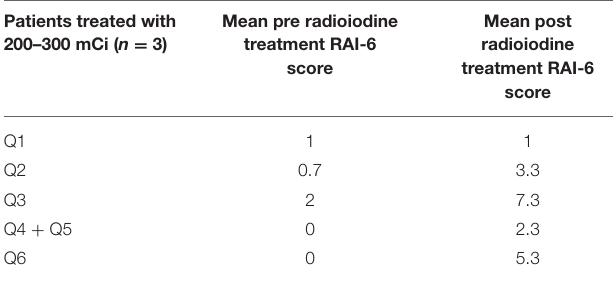
Patients treated with 200–300 mCi ( n = 3)